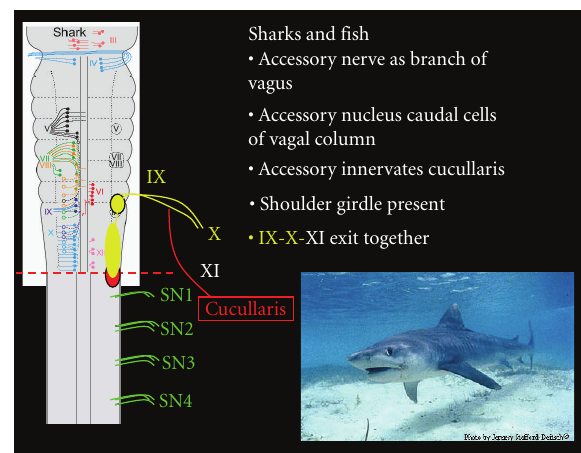
Figure 6: The skate is one of the earliest vertebrates to develop an accessory nerve, which arises from the intestinal branch of the vagus and innervates the Cucullaris (SCM/Trapezius homolog) muscle attaching to the lower branchial arches. The cell bodies contributing axons to the accessory n. in the skate are located in the caudal aspect of the dorsal motor nucleus of the vagus